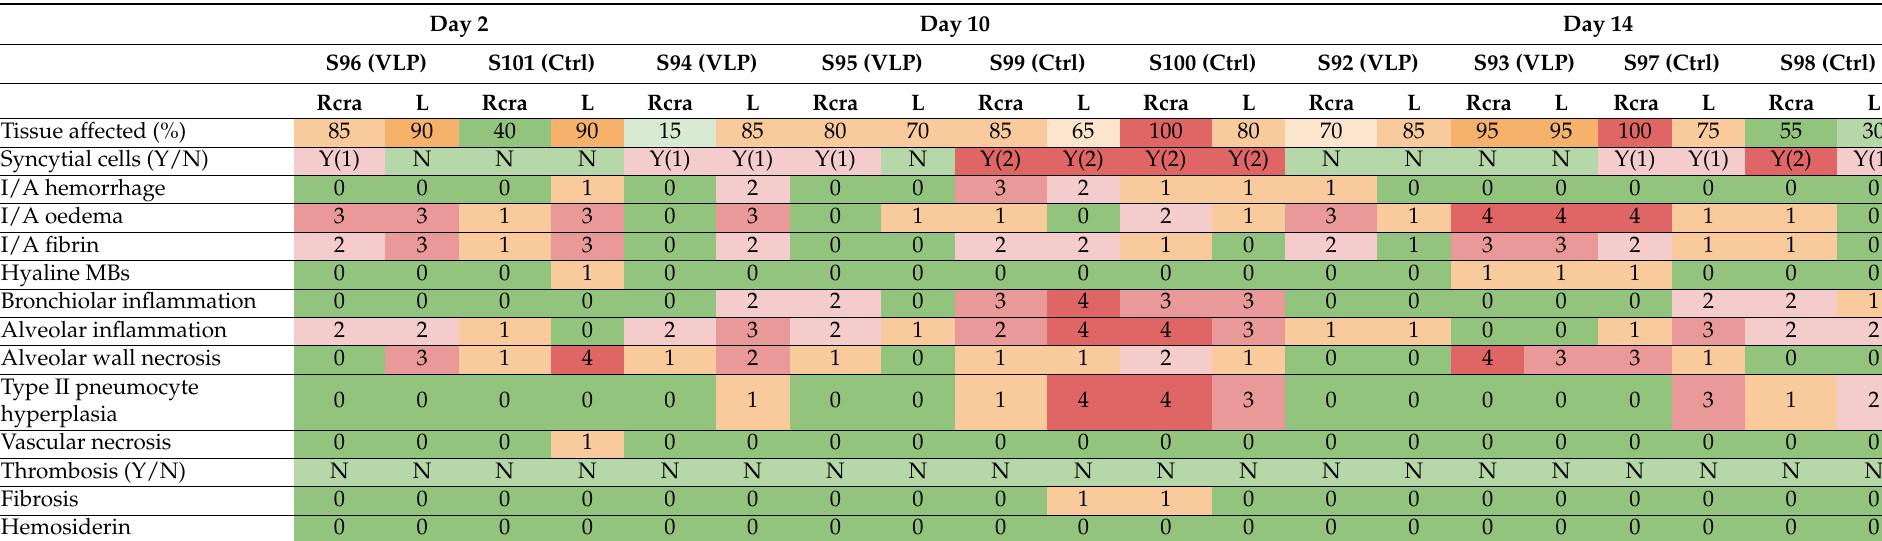
Table 1. Pathology scores for hamster lungs. Lesions were scored for severity on a scale of 1–4 and colored